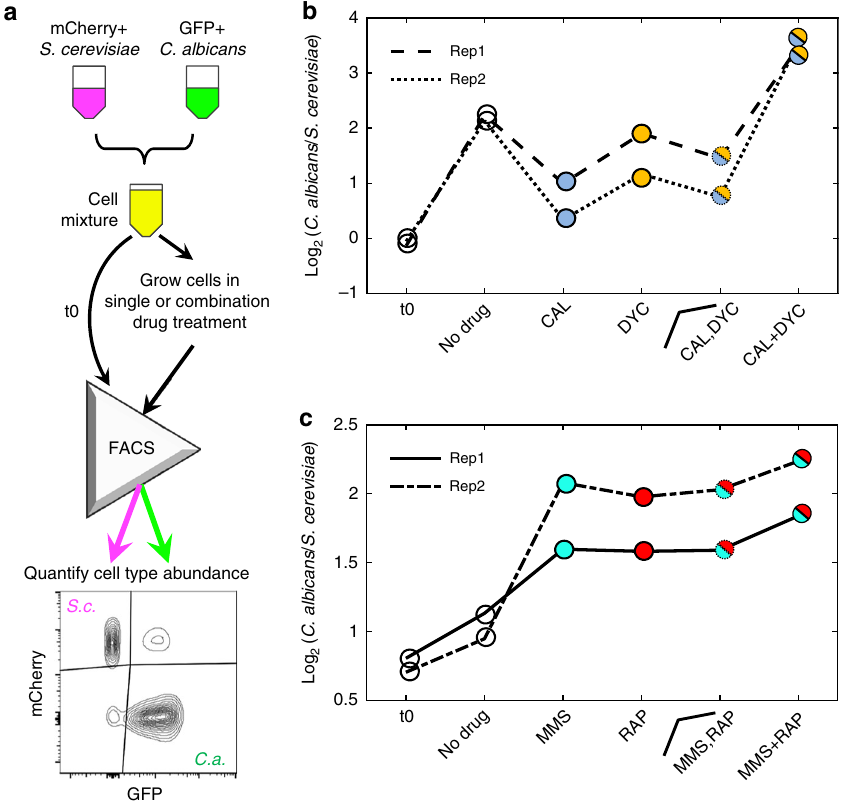
Fig. 4 Co-culture experiments validate the selectivity model predictions. a mCherry expressing S. cerevisiae and GFP expressing C. albicans cells were co- cultured in single or combination drug treatments in liquid media and growth of each species was quanti fi ed using fl ow cytometry. b Selectivity scores (log 2 ( C. albicans / S. cerevisiae )) for mixed culture assays before treatment (t0), at no drug condition, CAL, DYC, and CAL + DYC co-culture experiments are shown ( n = 2). Also shown is the average selectivity from CAL and DYC conditions, which is the expected selectivity in the absence of drug interactions. Comparison of the no drug condition to t0 shows that the amount of C. albicans in co-culture increases without any selective pressure, which is expected due to the shorter doubling time of C. albicans . Comparison of CAL and DYC to no drug condition validates the model prediction of single-drug selectivity for S. cerevisiae . Comparison of CAL + DYC to no drug condition indicates that the combination is selective for C. albicans , as predicted by the selectivity model (inverted selectivity). c MMS and RAP both individually select for C. albicans . As predicted by the model, the MMS + RAP combination has greater selectivity for C. albicans (selectivity increase due to antagonism). ( n =